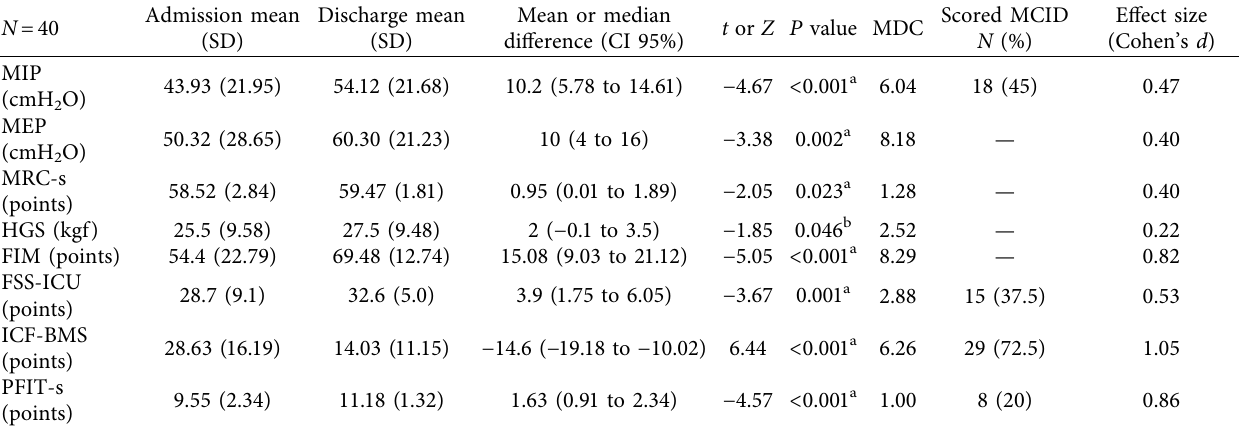
Table 2: Analysis of effect on respiratory and peripheral muscle strength and functionality.